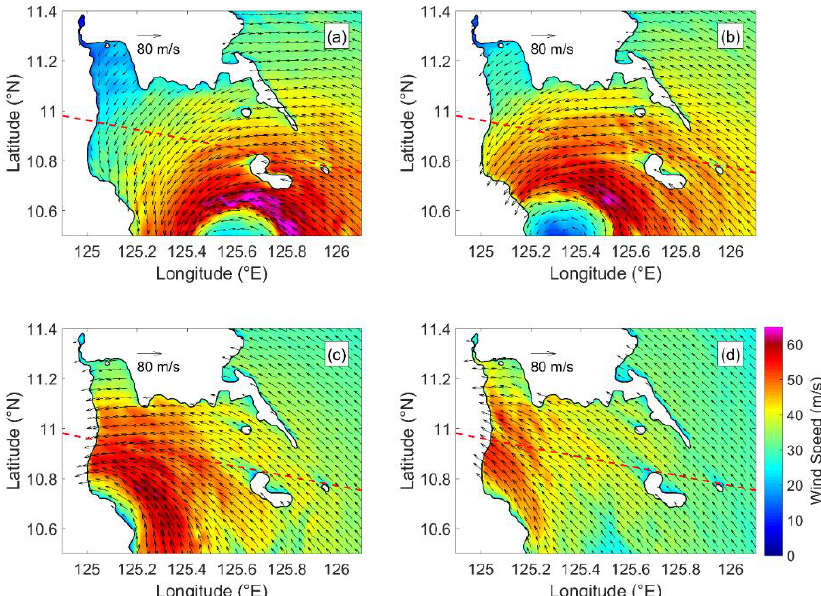
Figure 11. Snapshots of the 10-m winds by WRF-ARW 1 km at ( a ) 02:00 UTC 8 November 2013; ( b ) 03:00 UTC 8 November 2013; ( c ) 04:00 UTC 8 November 2013 ( d ) 05:00 UTC 8 November 2013. The dashed red line denotes the JMA best track. The color shading indicates the 10-m wind speed in m/s. The 10-m winds shown in this figure have been interpolated to the grids of the storm surge model. The arrows depict the wind direction per every 15 grids over the domain.